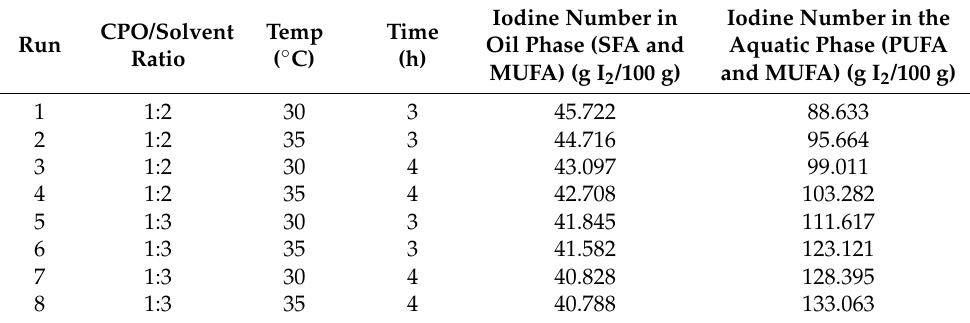
Table 1. Iodine number of CPO products in the oil phase and the aqueous